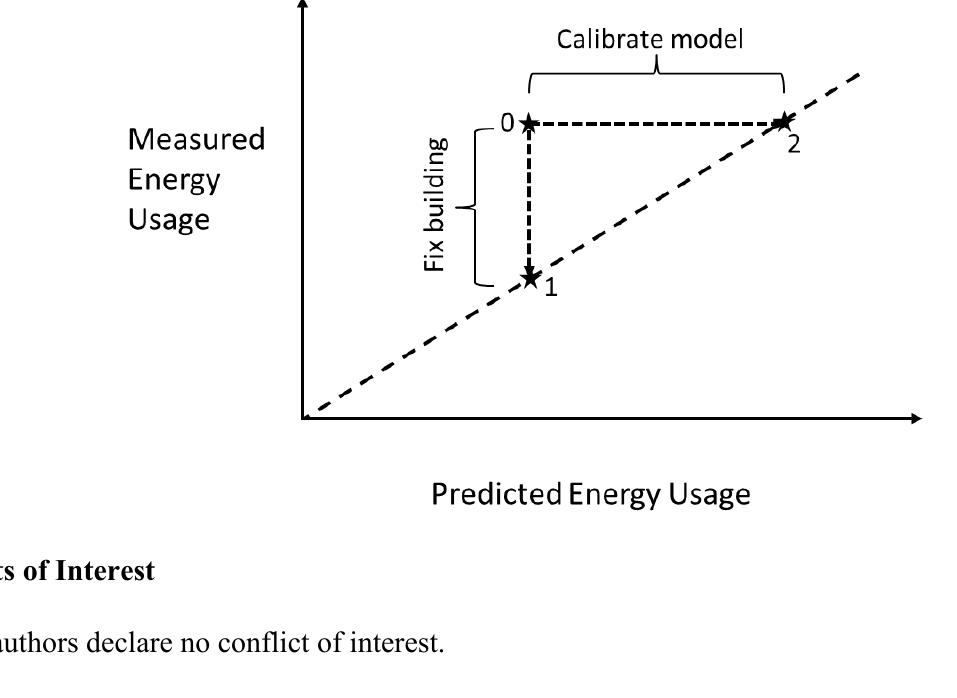
Figure 10. Measured vs. Predicted Building Energy